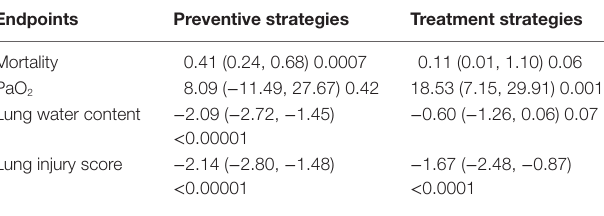
taBLe 5 | Effects of preventive strategies vs treatment strategies only.